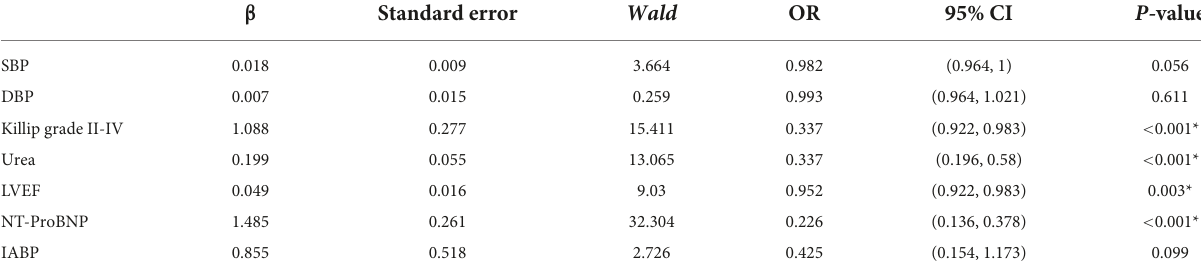
TABLE 2 Multivariate logistic regression analysis of influencing factors in major adverse cardiovascular events (MACE) group. β Standard error Wald